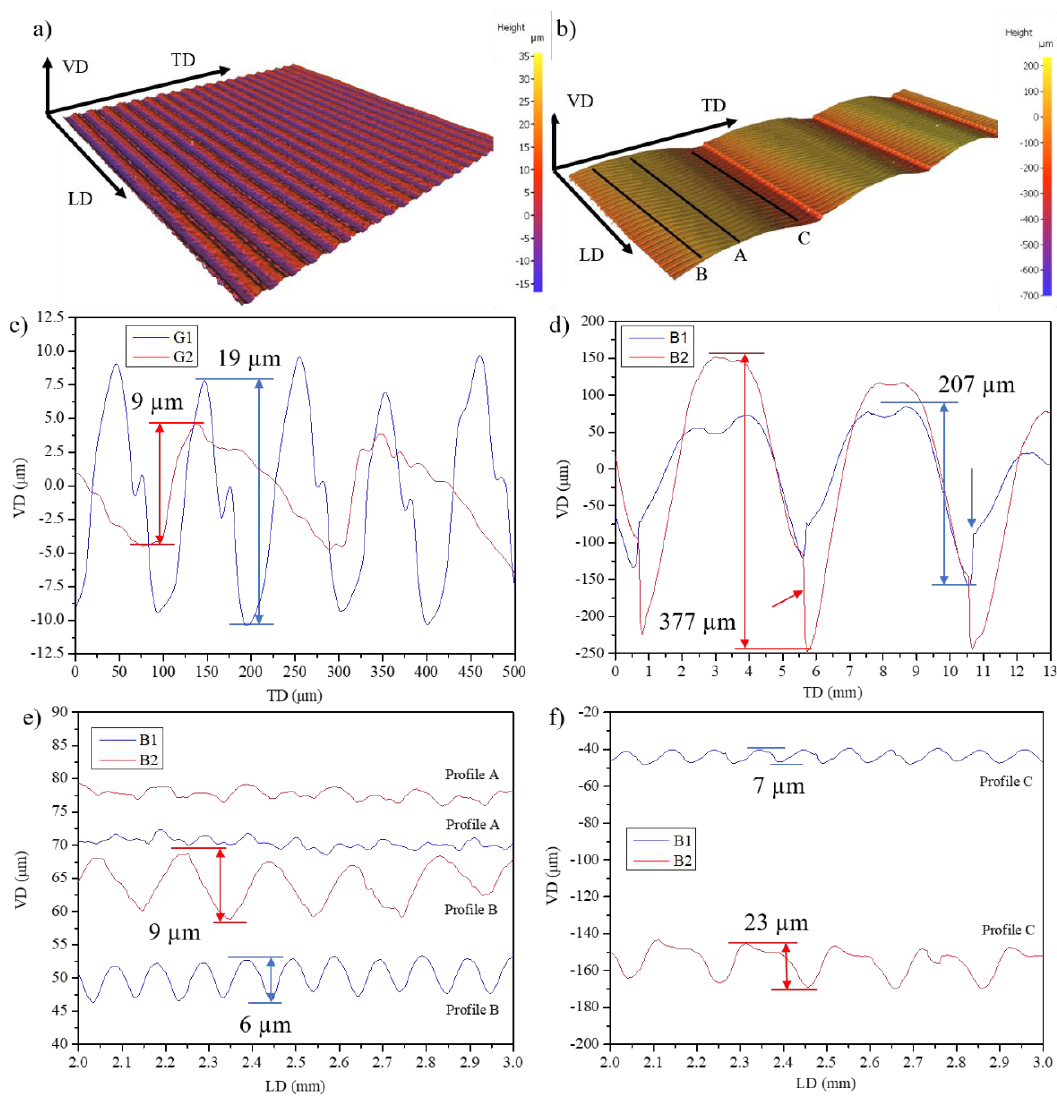
Figure 4. ( a , b ): 3D reconstruction of micro-canals and bridge structures. LD: longitudinal direction along the main direction of the structures. TD: transversal direction perpendicular to the main direction of the structures. VD: vertical direction. ( c ): TD profiles of G1 and G2 specimens. ( d ): TD profiles of B1 and B2 samples. ( e ): LD profiles A and B of B1 and B2 samples. ( f ): LD profiles C of B1 and B2 samples.